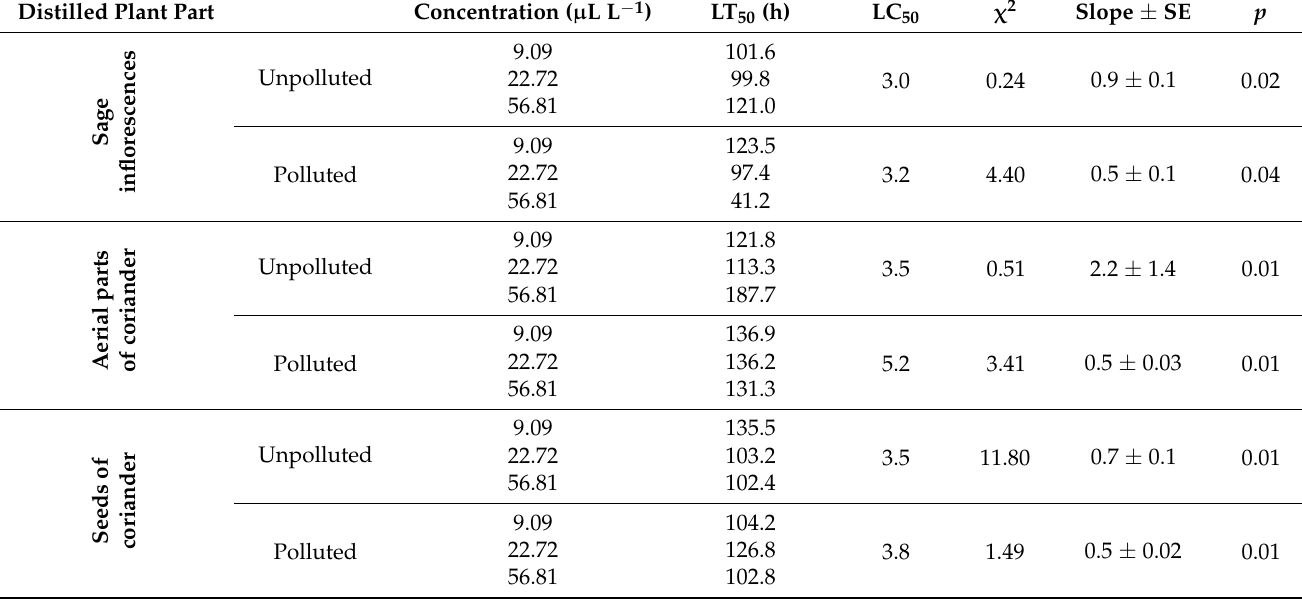
Table 5. LT 50 (h) and LC 50 ( µ L L − 1 ) values resulting from the fumigation bioassay against E. kuehniella adults, for the three different tested EO, originating from the two experimental plots (n =